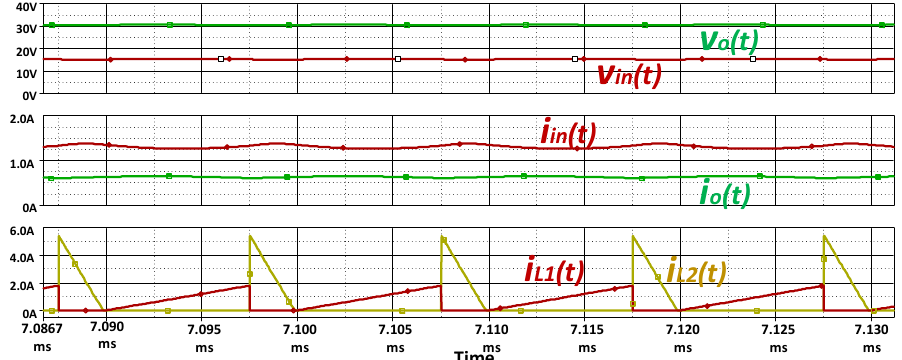
Figure 11. Simulation results. Input and output voltages ( v in (t), v o (t) ); input and output currents ( i in (t), i o (t) ); currents of the primary and secondary inductors ( i L1 (t), i L2 (t) ).